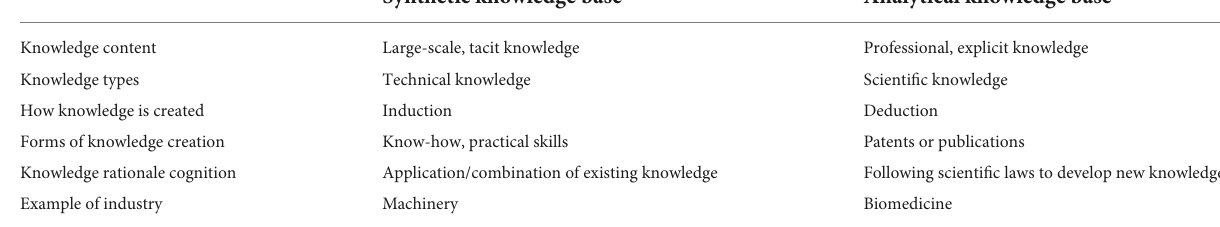
TABLE 1 Typical differences between two types of industrial knowledge